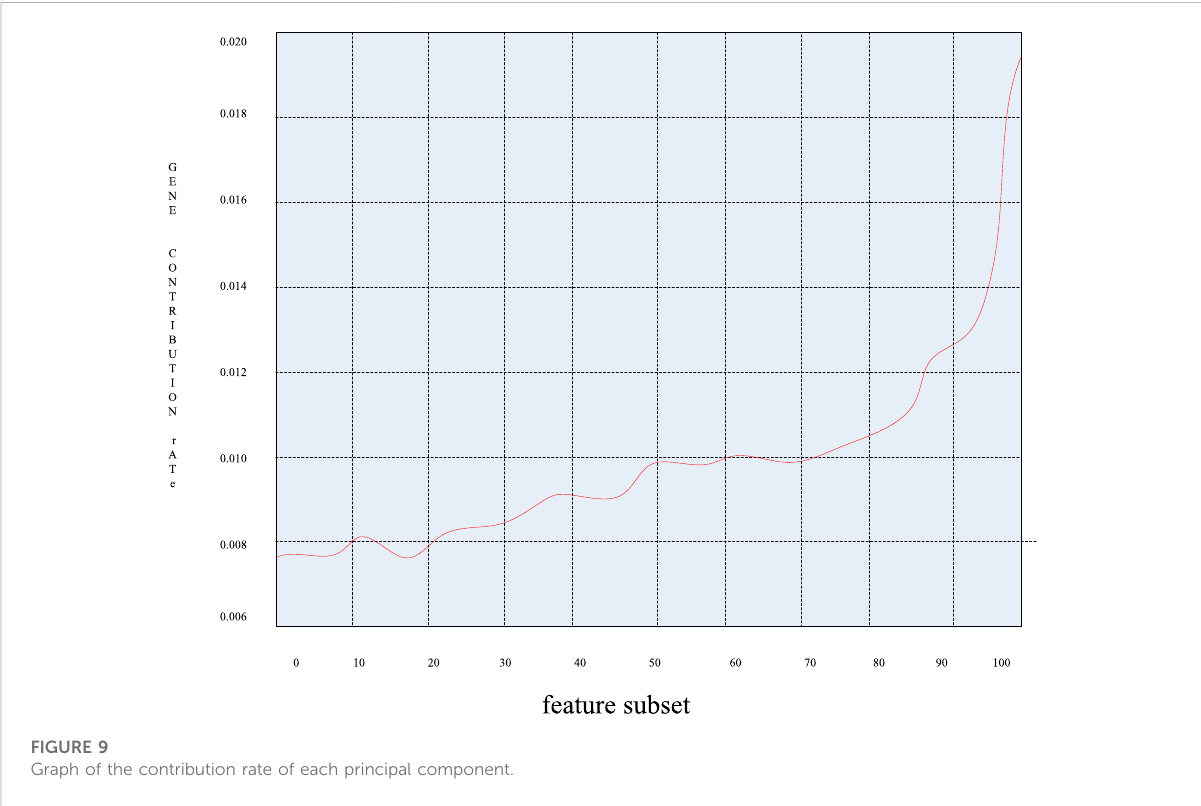
FIGURE 9 Graph of the contribution rate of each principal